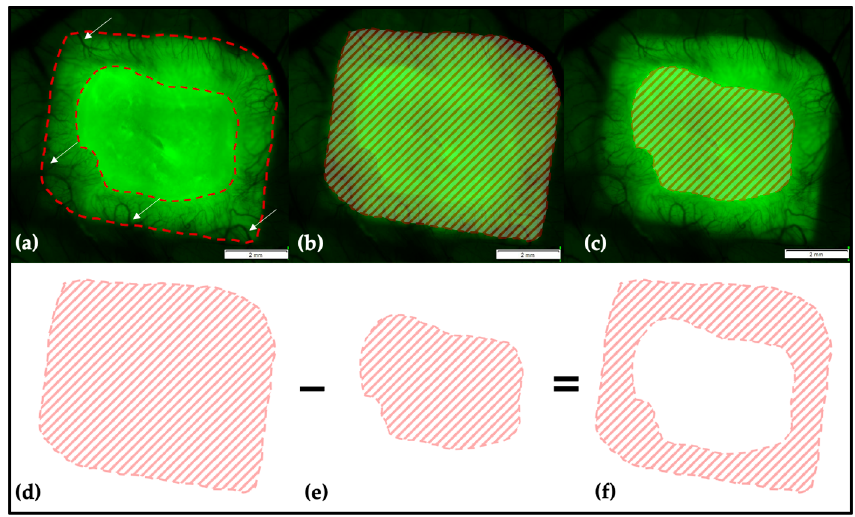
Figure 14. Multiple image array analysis of the CM. ( a ) The CM is visible as a brighter prismatic structure. Here, vessels can be seen growing into to transplant (arrows). The inner border of the vascularized area is marked and clearly distinguishable from the non-vascularized matrix. ( b ) To calculate the portion of vascularized area of the whole transplant, the outer border of the CM was traced, and the software package automatically calculated the encircled area as shown. ( c ) Then, the inner border of the vascularized area was marked. The software here also calculated the encircled area. To receive the size of the vascularized area ( f ), the non-vascularized area ( e ) in the center of the CM was subtracted from the area of the whole CM ( d ). The scale bar corresponds to a length of 2 mm.